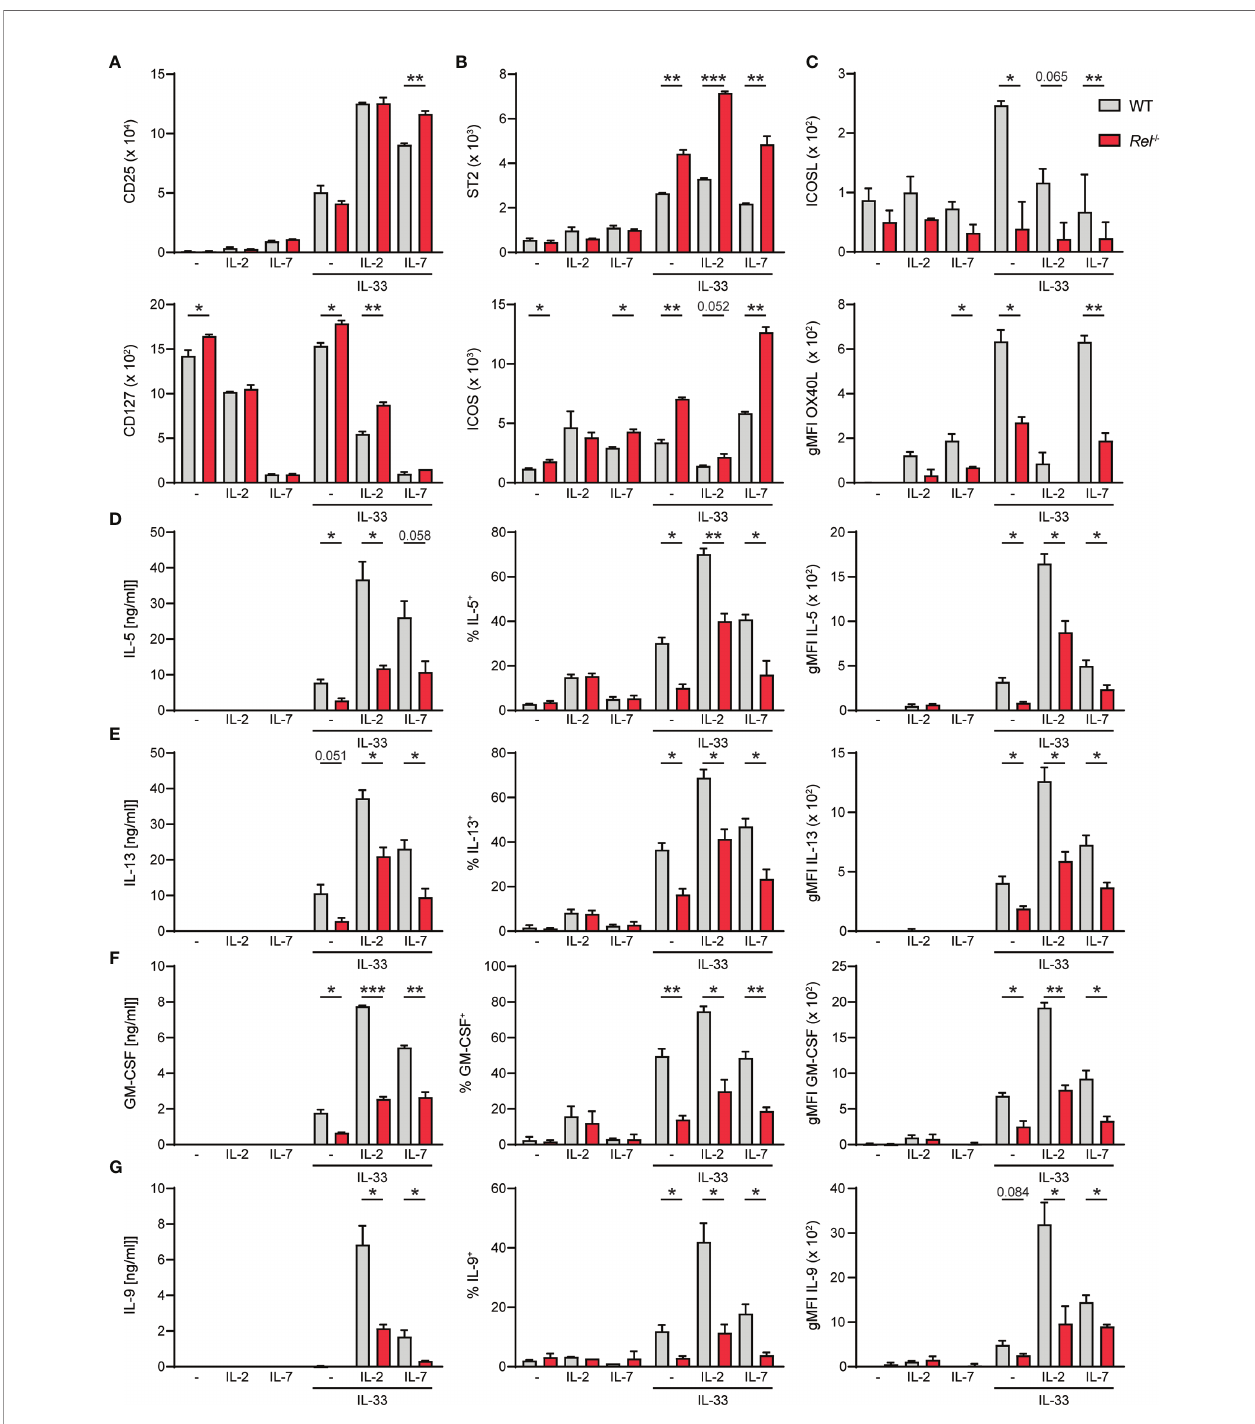
FIGURE 6 | c-Rel de fi ciency limits group 2 innate lymphoid cell (ILC2) effector functions following ex vivo activation. Lung ILC2s from wild-type (WT) and Rel − / − mice were isolated by fl ow cytometry and cultured ex vivo in the absence ( − ) or presence of IL-2, IL-7, or IL-33 and combinations thereof (all 10 ng/ml). Expression levels of surface (A) CD25 and CD127, (B) ST2 and ICOS, and (C) ICOSL and OX40L on isolated WT (gray) and Rel − / − (red) lung ILC2s after 24-h stimulation under indicated conditions. Analysis of (D) IL-5, (E) IL-13, (F) granulocyte-macrophage colony-stimulating factor (GM-CSF), and (G) IL-9 expression by WT (gray) and Rel − / − (red) lung ILC2s left untreated or cultured with IL-33 for 48 h. Cytokine concentration in culture supernatants is depicted in the left panel, frequencies of cytokine- producing cells are depicted in the middle panel, and cytokine expression levels are depicted as gMFI in the right panel. Data points are representative of two independent experiments with two biological replicates for each stimulation condition. Data are shown as mean ± SD with *p < 0.05, **p < 0.01, and ***p < 0.001 as determined by two-tailed t-test (unpaired). gMFI, geometric mean fl uorescence